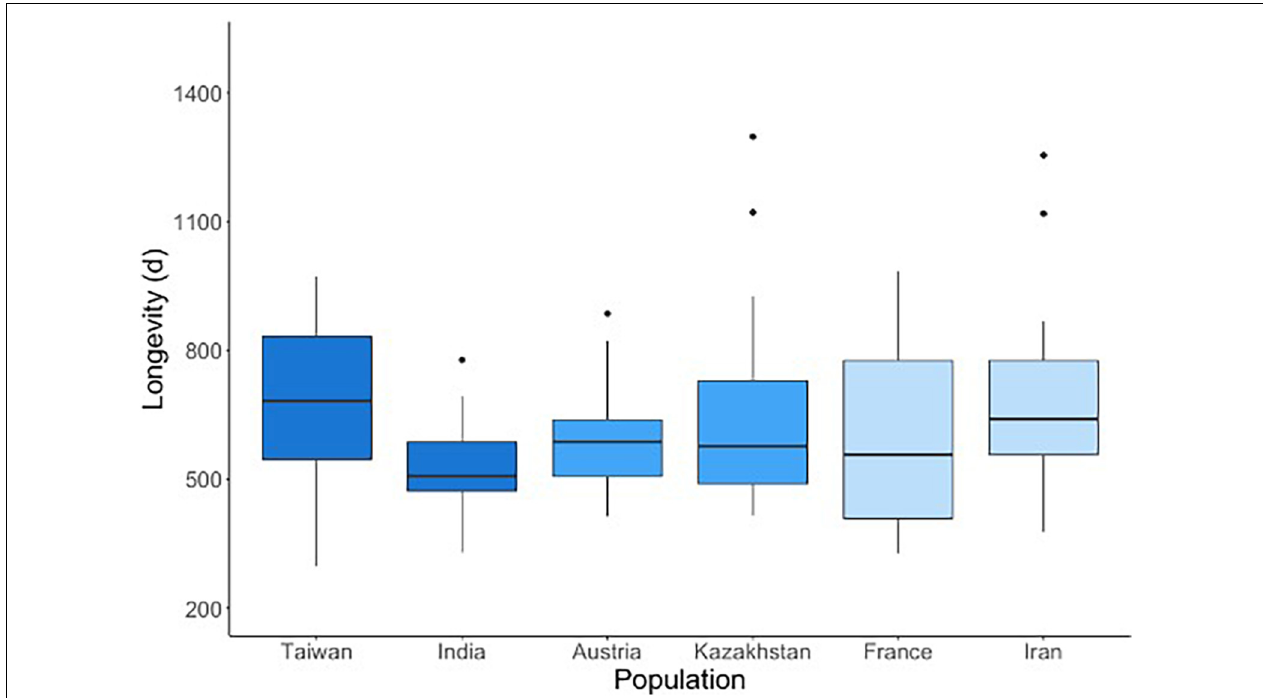
FIGURE 5 | Longevity of Mus musculus populations. The two populations per subspecies are shown in the same shade of